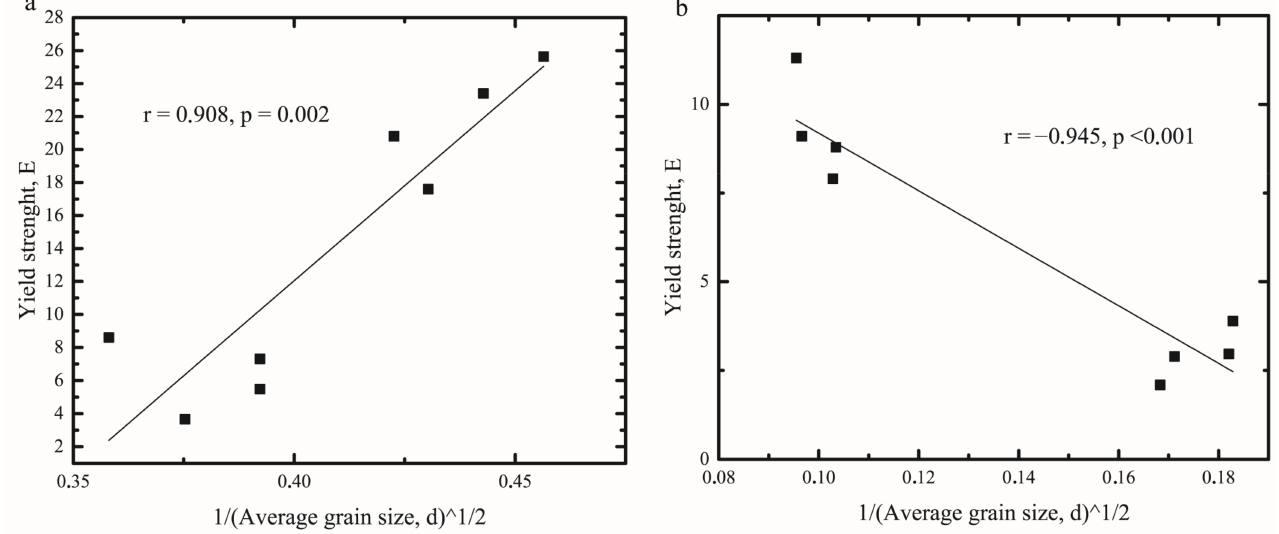
Figure 5. Relation between average grain size ( d ) and yield strength ( E ) for beeswax ( a ) and beeswax hydrocarbons ( b )